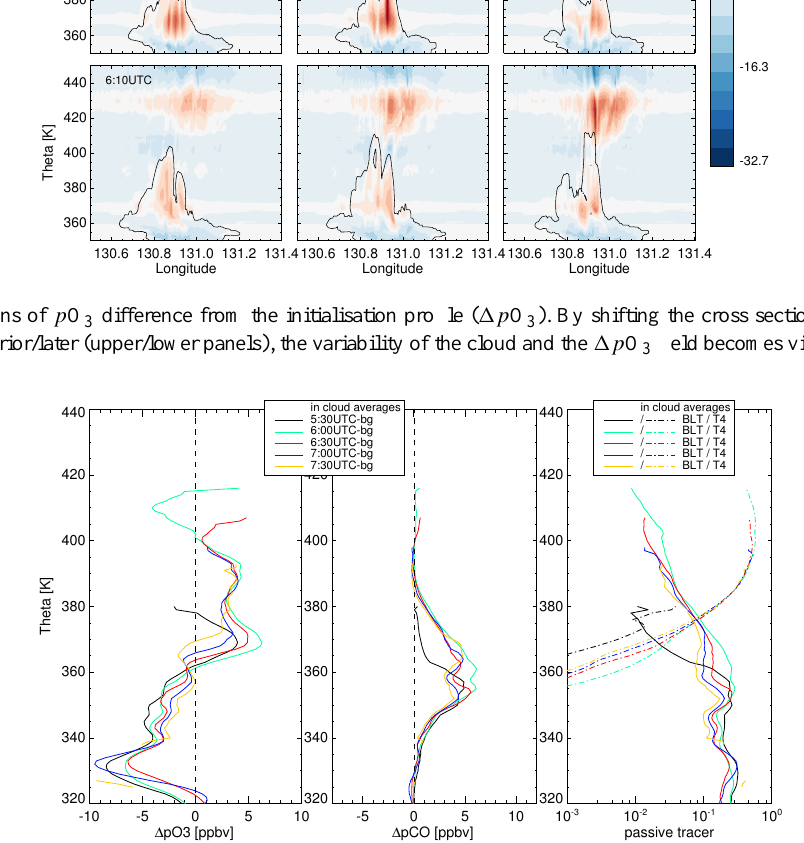
consistent with the localised tracer perturbations in Fig.